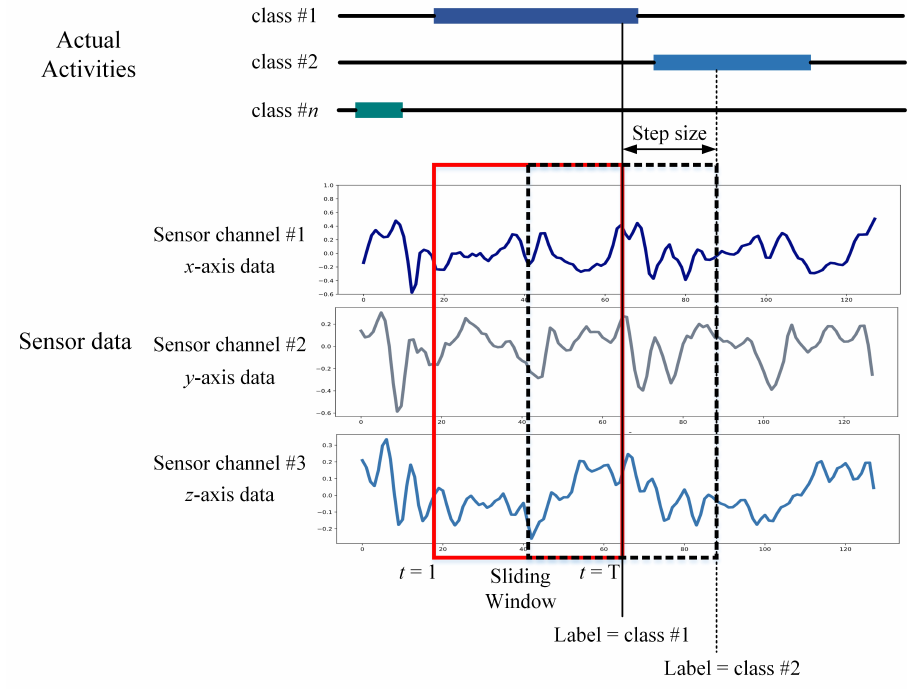
Figure 7. Data segmentation process by a sliding window.